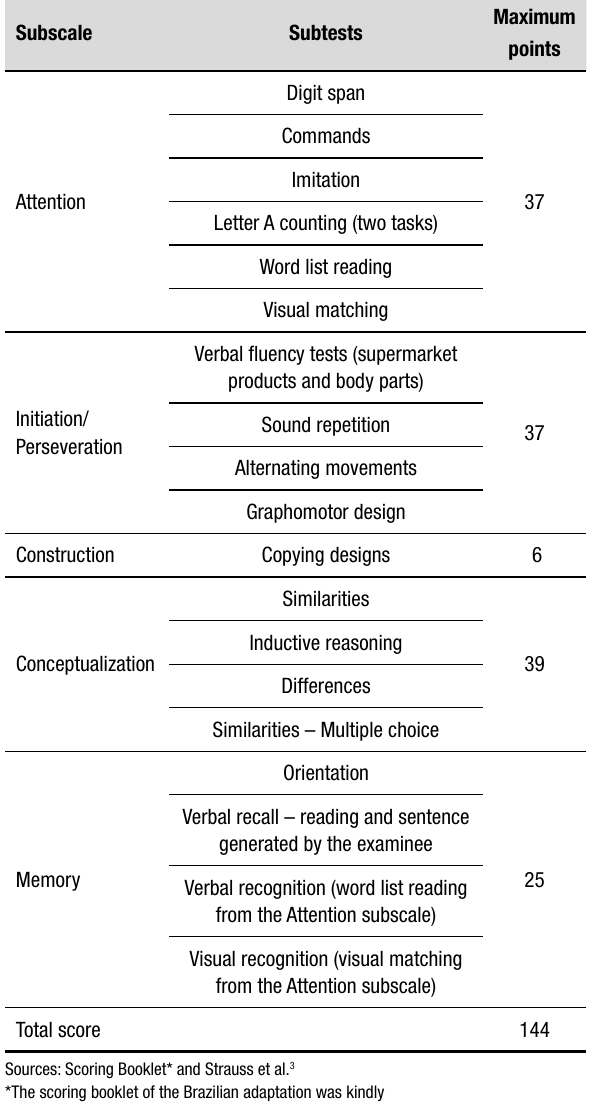
Table 1. Brief description of the Mattis Dementia Rating Scale subtests.